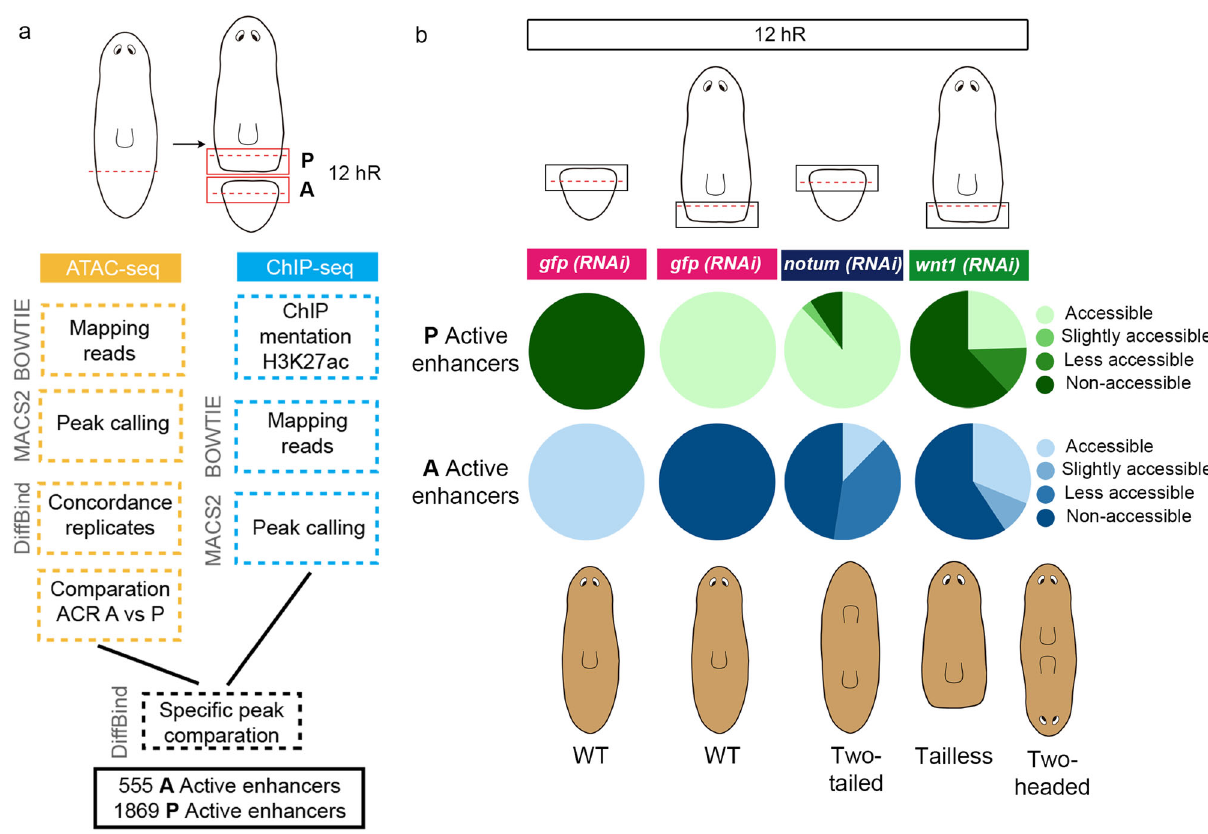
Fig. 1 | Thechromatinofcellsin thewound remodelsaccording tothepolarity of the pre-existing tissue. a Work fl ow to identify putative anterior and posterior speci fi c enhancers at 12 hR. Next to each step the program used is indicated. b Accessibility changes of the putative anterior and posterior speci fi c active